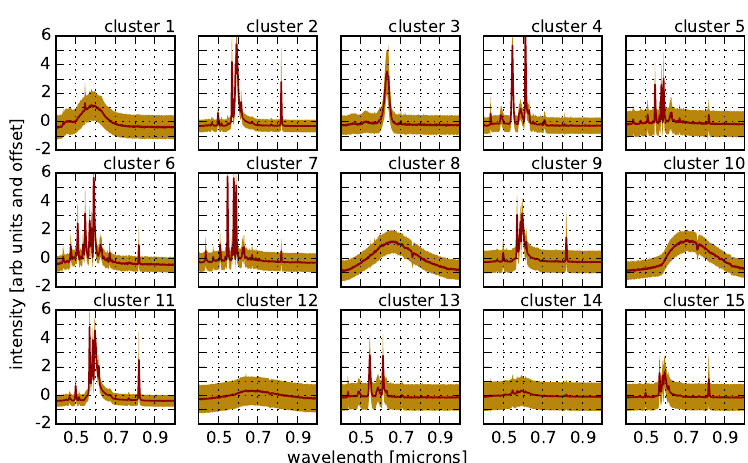
Figure 14. The result of clustering our ∼ 42,000 spectra into 15 clusters using k -means clustering. The red lines represent the cluster centers, while the yellow bands represent the dispersion of the cluster members for each cluster. It is clear that k -means is recovering dominant spectra for High Pressure Sodium (HPS) lamps, as well as fluorescent and metal halide lamps (see Figure 15). Nevertheless, several of the cluster centers do not correspond to any NOAA templates, but are largely consistent with LED-type lights.